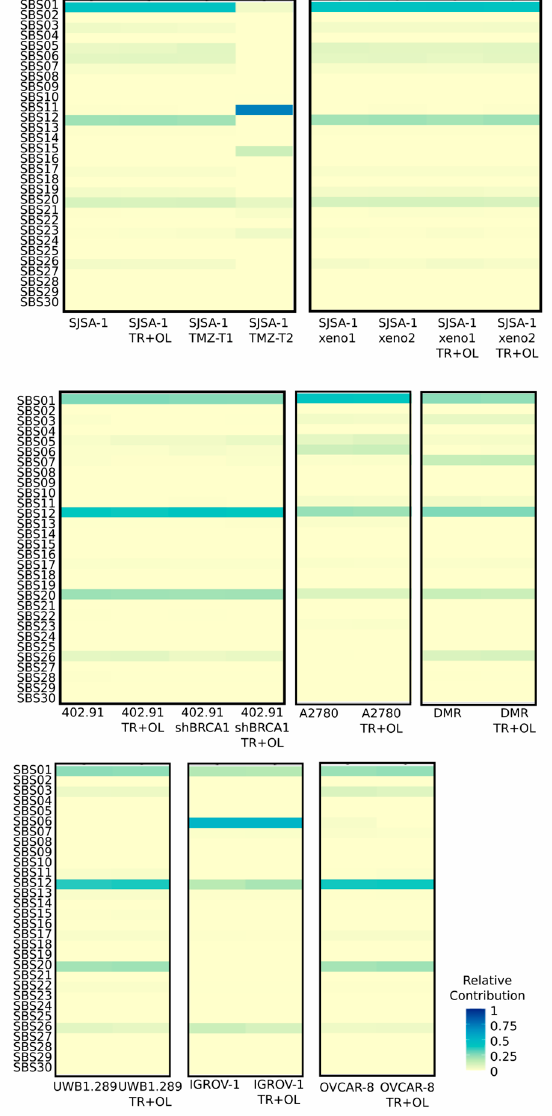
Figure 5. Mutational signatures analysis. Heatmap of normalized signature performed using COSMIC v2.0 as reference for the fitting analysis. Results are shown as the relative contribution of the specific SBS signature in treated and untreated samples for each specific cell line and treatment type. TR + OL: after three cycles of treatment with trabectedin + olaparib combination. TMZ: after temozolomide treatment.